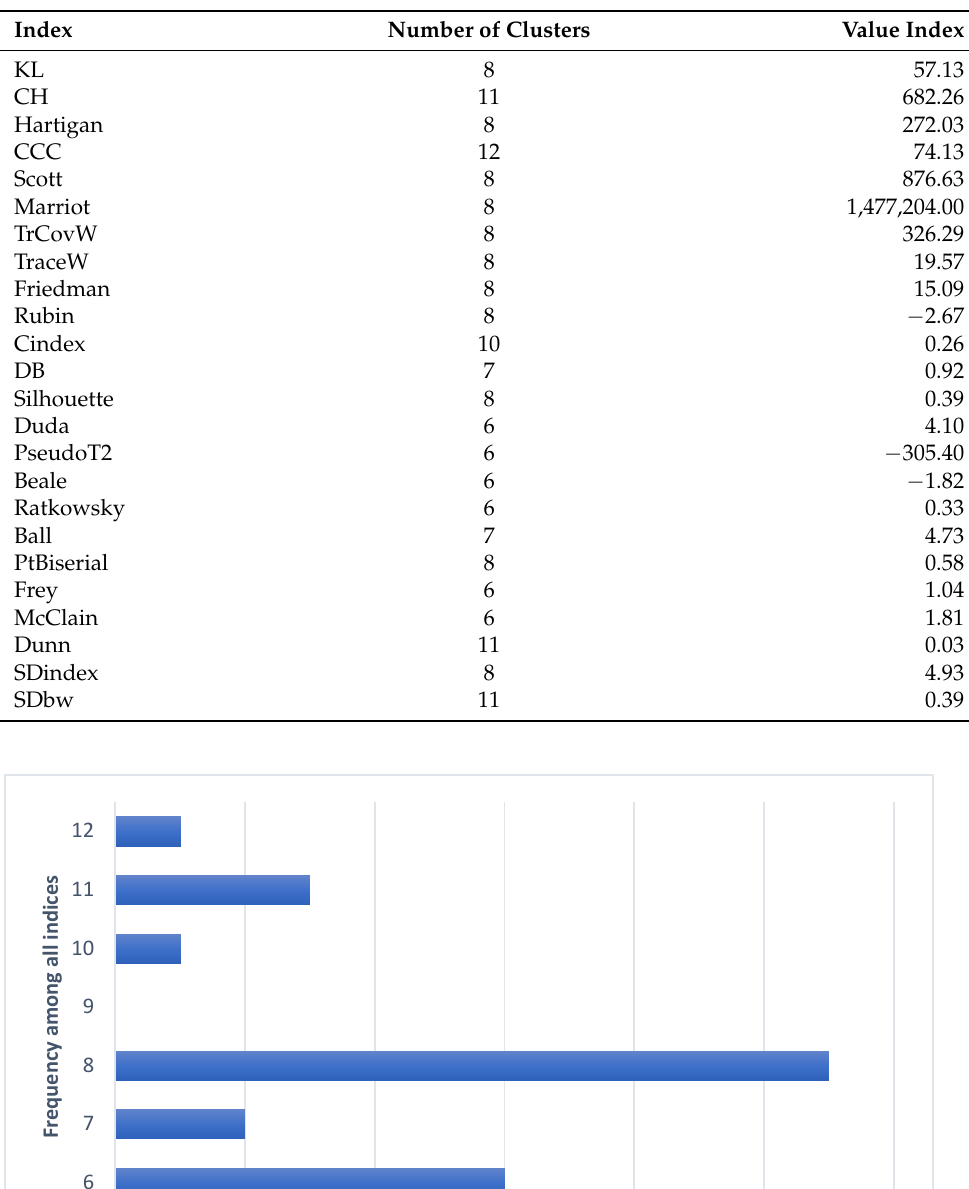
Table 10. Number of Clusters Proposed by the Different Indices.